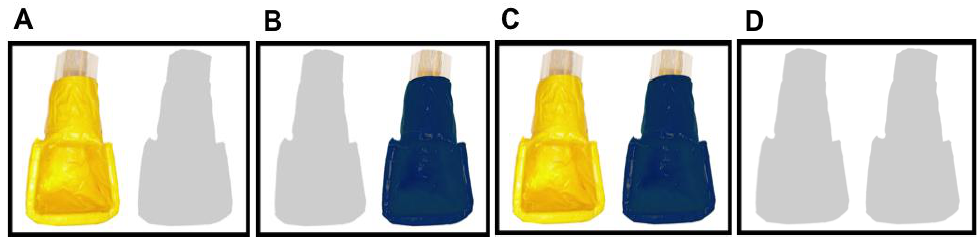
Figure 2. Images of the four stimuli representing four different food reward outcomes: ( A ) 1/0; ( B ) 0/1; ( C ) 1/1; ( D )